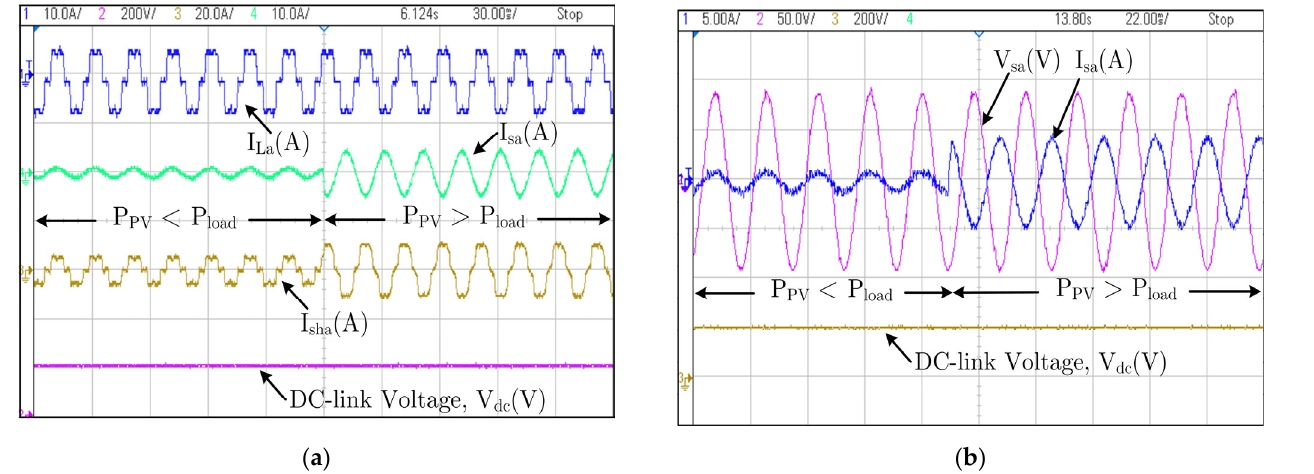
Figure 12. Under varying solar irradiance from 500 W/m 2 to 100 W/m 2 ( a ) load current, grid current, compensating current of phase “a’ and DC-link voltage; ( b ) phase relation between voltage and current and dc–link voltage.